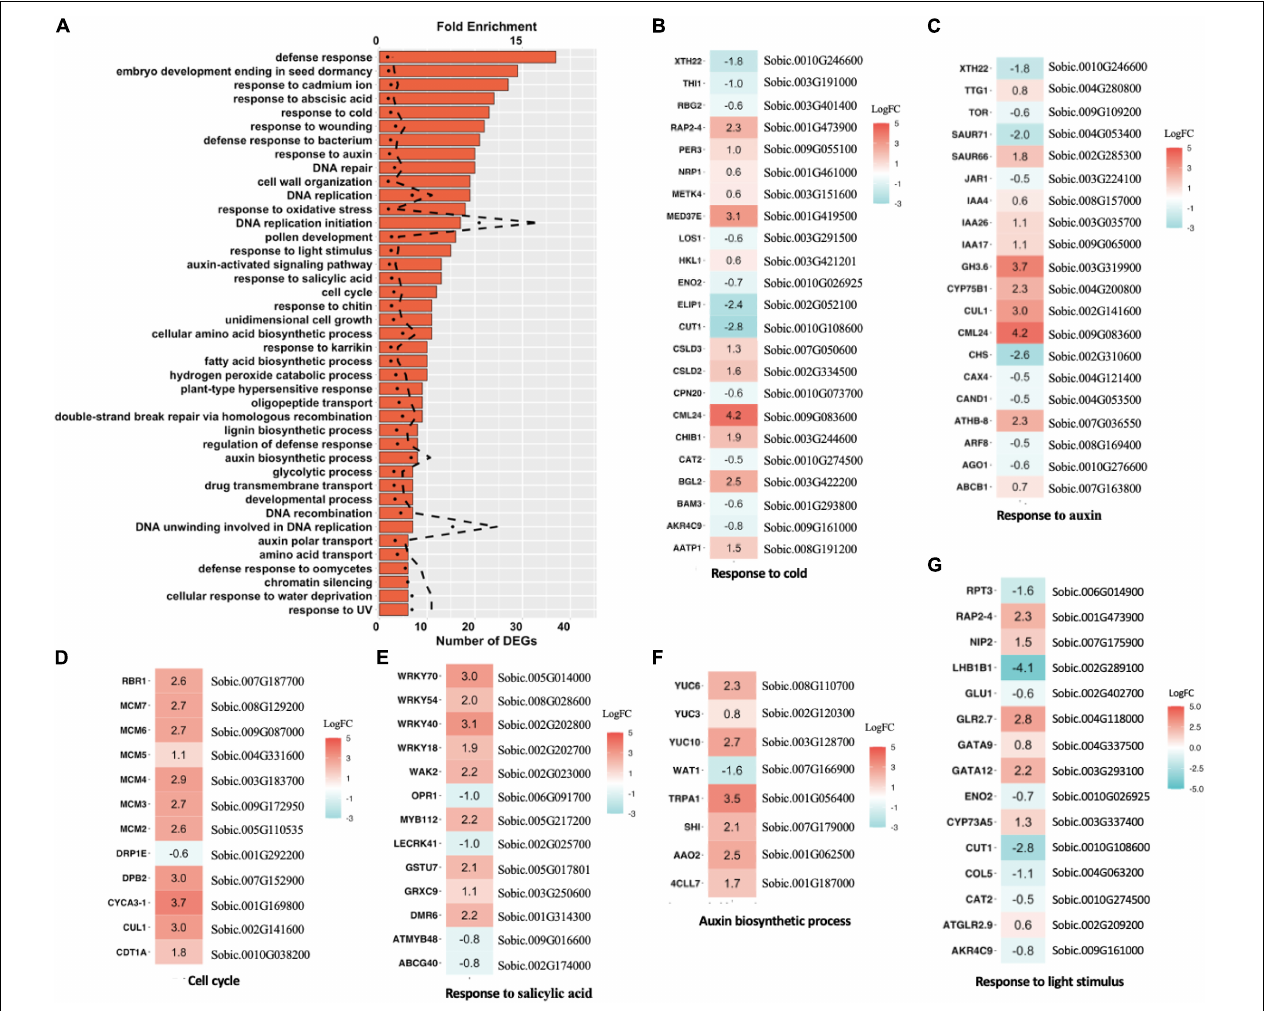
FIGURE 5 | Differentially expressed genes (DEGs) and enriched pathways in epi-F3 lines. (A) Significantly enriched Gene Ontology (GO) pathways for DEGs identified in the high-performance epi-F3 vs. low-performance epi-F3 line comparison. Bar graph represents the number of DEGs, and dotted line represents fold enrichment for the enrichment test. One-sided Fisher’s exact test was performed to compute FDR as implemented in DAVID GO, and p < 0.05 is the cut-off for significance. (B–G) Expression change of individual genes in the significantly enriched pathways for response to cold, response to auxin, cell cycle, response to salicylic acid, auxin biosynthetic process, and response to light stimulus. Sorghum gene ID and corresponding Arabidopsis homolog gene name are listed together. Sorghum bicolor NCBIv3.49.gff3 file was used for annotation. NCBI BLASTP was used to identify the homolog of sorghum genes in Arabidopsis (TAIR10 version 38). Genes upregulated in the high-performance line are in red, and downregulated genes are in